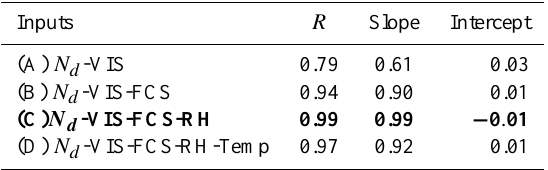
Table 1. Parameters of the least-square fit (Pearson correlation co- efficient, R , slope and intercept) between the measured PFR AOD and the estimated ANN AOD using different configurations of input parameters. The setup selected is highlighted in